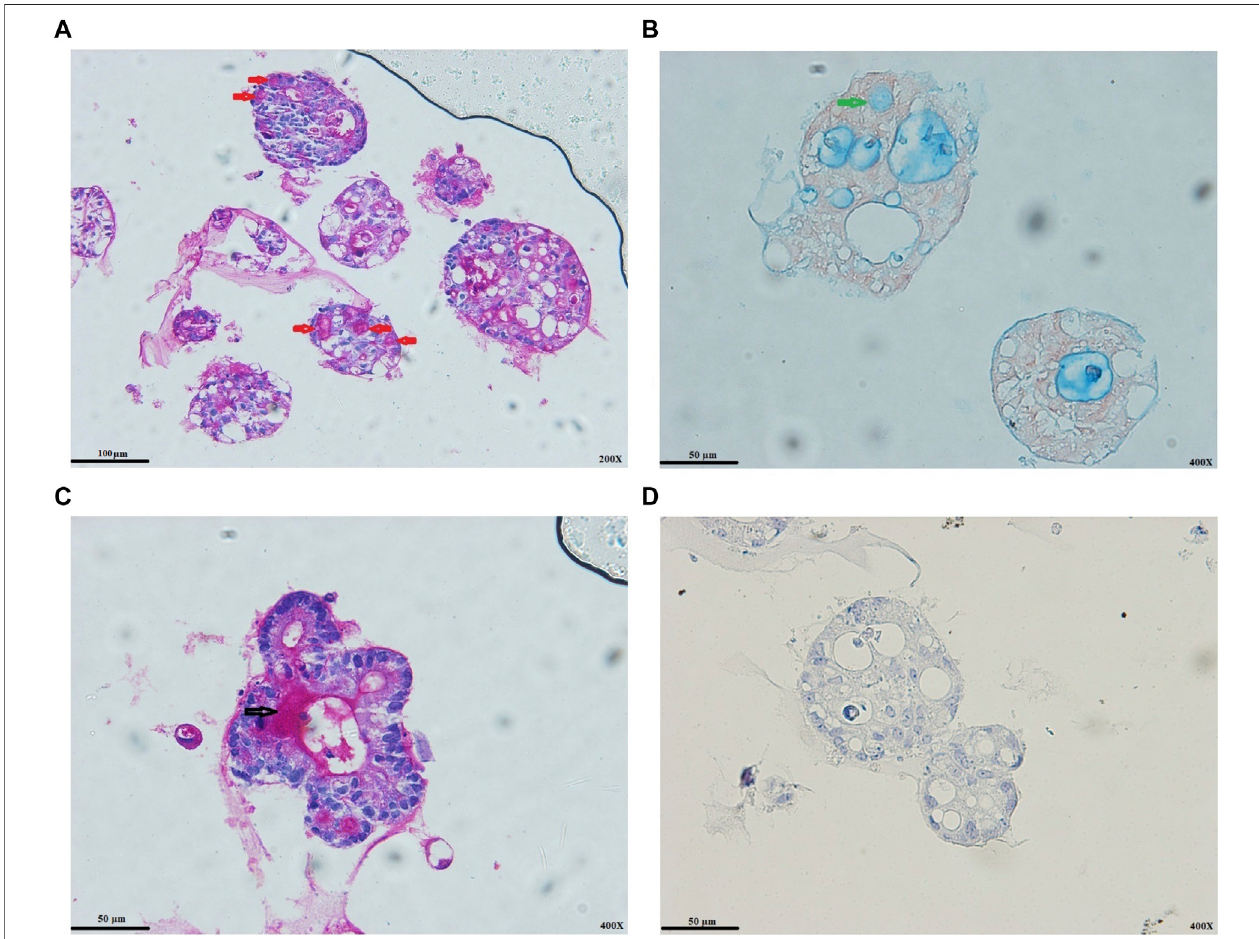
FIGURE 3 | Colon cancer organoids differentiation status. (A) PAS-positive goblet cells (red arrows). (B) AB-positive goblet cell (green arrows). (C) Secretion process of goblet cell mucus into the lumens of organoids (black arrow). (D) IHC staining for alkaline phosphatase. Asexpected, Wnt activity strongly inhibits enterocyte differentiation. Scale bar: 50 μ m and 100 μ m, ×400 and ×200 magni fi cation.